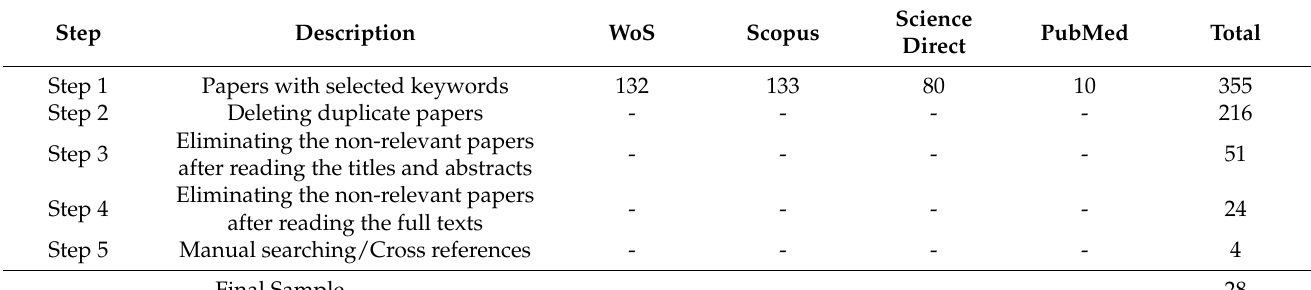
Table 1. Procedure followed throughout the review (source: own